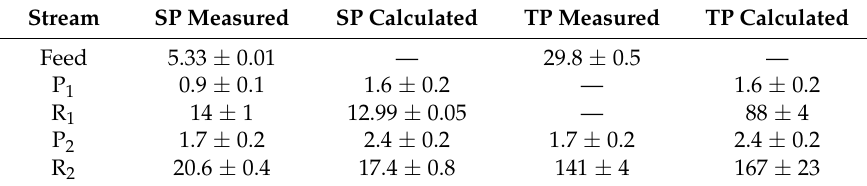
Table 2. The calculated and measured mixing-cup concentrations (g L − 1 ) of serum protein (SP) and true protein (TP) for the 100 kDa unmodified membrane during the 6-fold volume concentration of skim milk. The streams are feed, first stage permeate (P 1 ) and retentate (R 1 ), and second stage permeate (P 2 ) and retentate (R 2